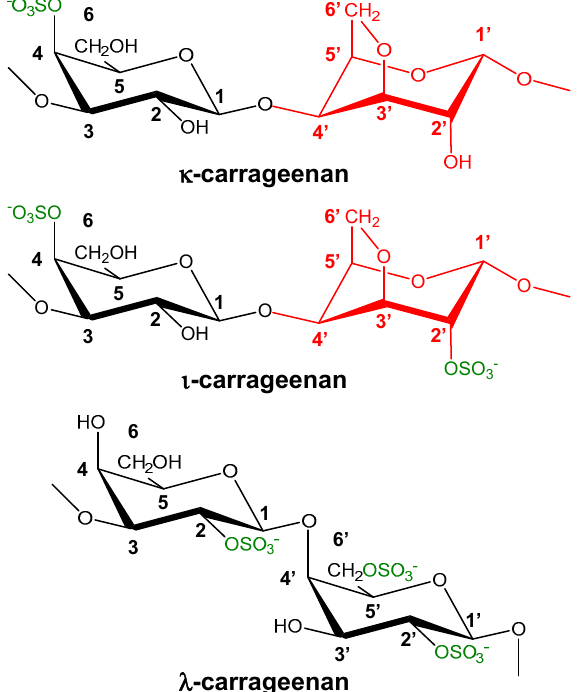
Figure 4. Schematic representation of the structural disaccharide repeating units of κ , ι and λ - carrageenans.